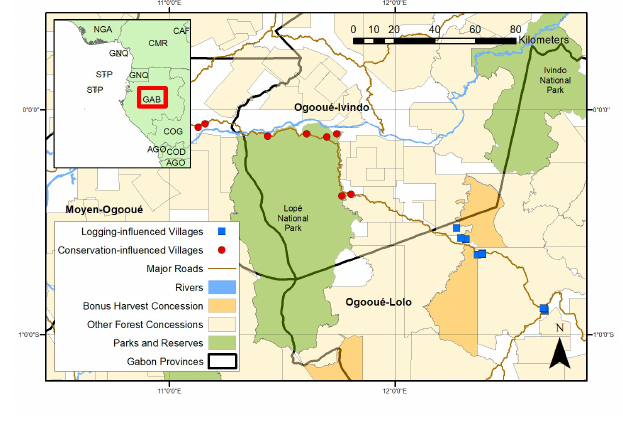
Fig. 1. Map showing the locations of the study villages in Gabon. Eight conservation-influenced villages were located near a national park, and 10 logging-influenced villages were located away from protected